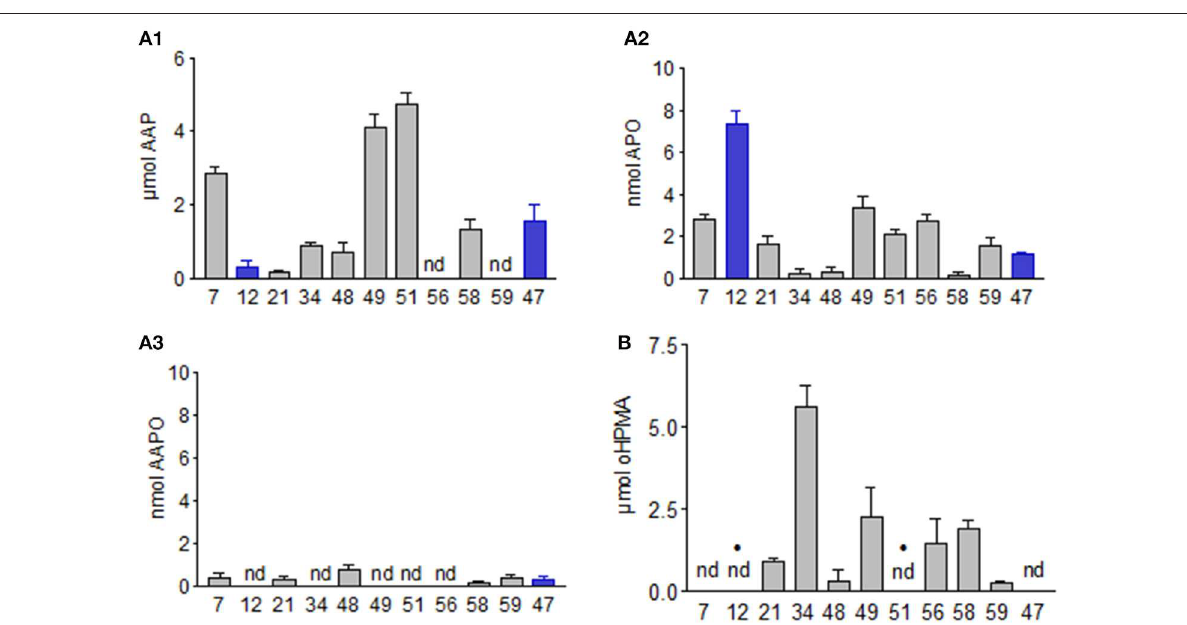
megaterium (21), B. methylotrophicus (58) , and B. cereus (59) . In the culture medium of A. aminovorans (49) the same conversion products were found as with AAP (see below).